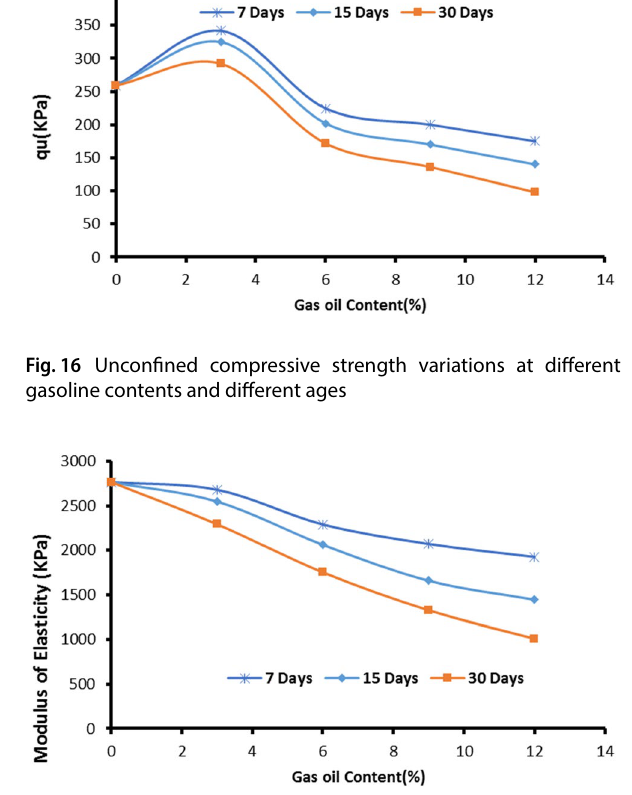
Fig. 17 Modulus of elasticity variations at different gasoline con- tents and different